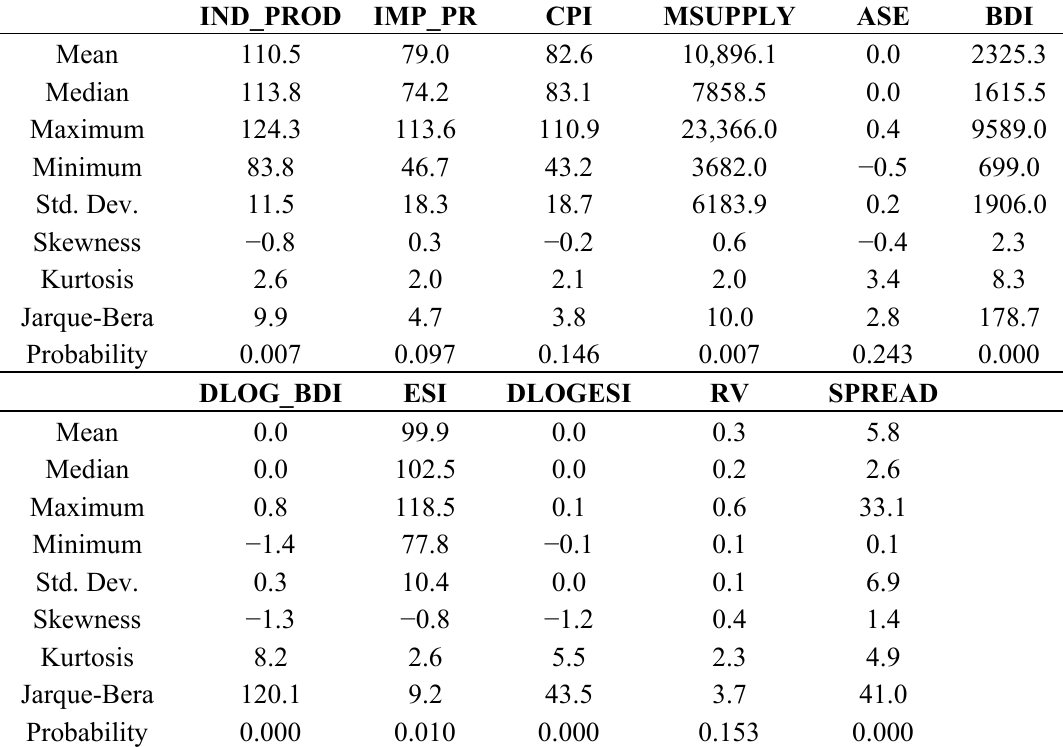
Table 1. Descriptive statistics of the explanatory